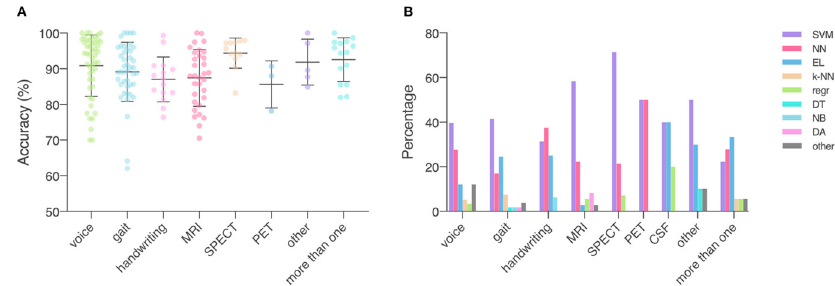
Figure 2. Data type, machine learning models applied, and accuracy. ( A ) Accuracy achieved in individual studies and average accuracy for each data type. Error bar: standard deviation. ( B ) Dis ‐ tribution of machine learning models applied per data type. MRI, magnetic resonance imaging; SPECT, single ‐ photon emission computed tomography; PET, positron emission tomography; CSF, cerebrospinal fluid; SVM, support vector machine; NN, neural network; EL, ensemble learning; k ‐ NN, nearest neighbor; regr, regression; DT, decision tree; NB, naïve Bayes; DA, discriminant anal ‐ ysis; other: data/models that do not belong to any of the given categories (reproduced from [36]).